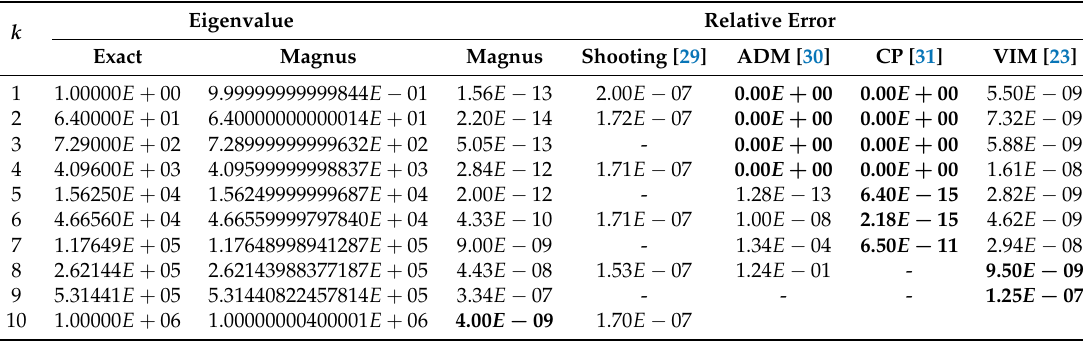
Table 9. Eigenvalues and relative error for the problem in Equation (36). (Minimum relative error for each eigenvalue is in